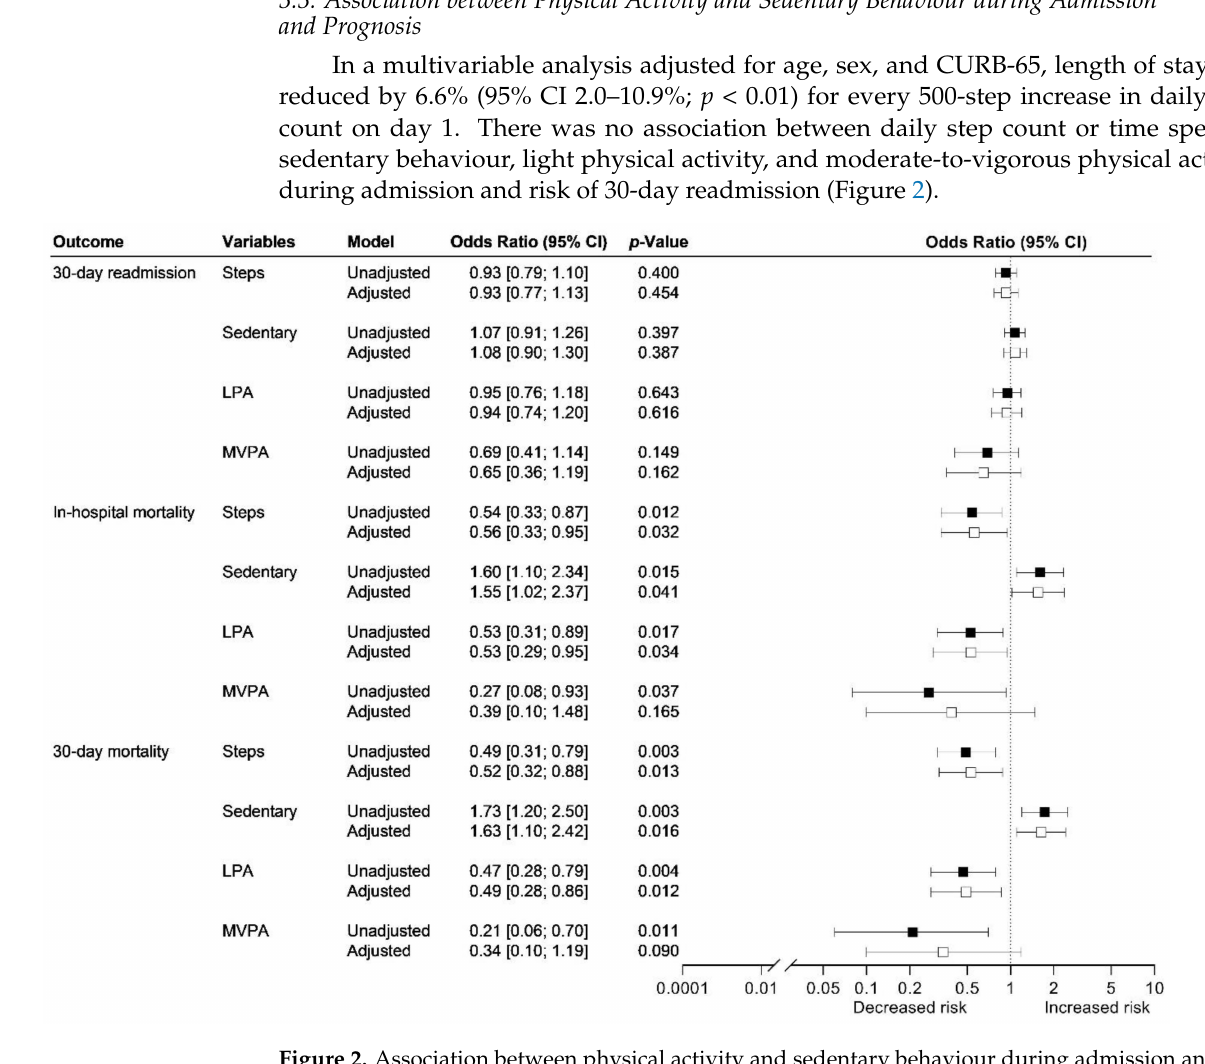
Figure 2. Association between physical activity and sedentary behaviour during admission and risk of readmission and mortality among 166 patients admitted with community-acquired